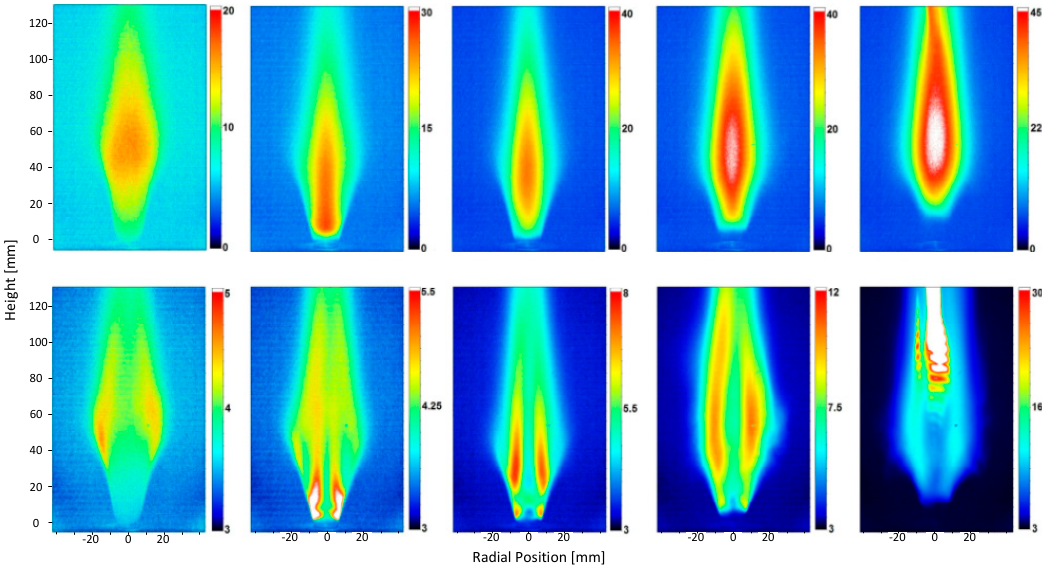
Figure 7. The time-averaged ( upper row ) and RMS ( lower row ) images of different flame structures with a central fuel injection (from left to right: U f /U c = 0, 0.045, 0.089, 0.22 and 0.36).